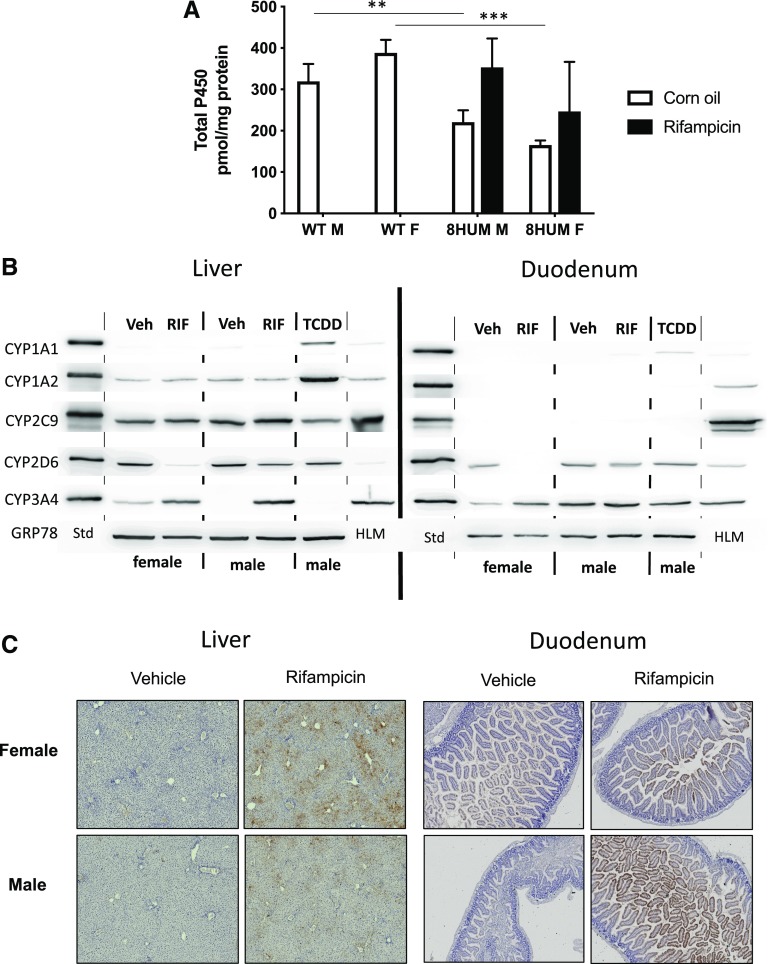
Expression of human cytochrome P450s in 8HUM mice. (A) Total hepatic P450 was determined from the carbon monoxide difference spectra (as described in Materials and Methods) in untreated male and female wild-type mice (WT; n = 3–8), and male and female 8HUM mice (n = 3) vehicle (white bars) and rifampicin-treated daily for 3 days (black bars; 10 mg/kg, i.p.). Data shown are mean ± S.D.; t test (two-tailed P values), statistically significant **P < 0.01; ***P < 0.001. (B) Immunoblot analysis of human P450 expression in liver and duodenum. Western blots were carried out on pooled microsomal fractions (n = 3) of liver and duodenum, as described in Materials and Methods, using antibodies specific for the human P450s shown. Std, His-tagged P450 standard; TCDD, 2,3,7,8-tetrachlordibenzodioxin-treated; Veh, vehicle-treated. (C) Immunohistochemical localization of CYP3A4 in liver and duodenum of vehicle- and rifampicin-treated 8HUM mice. Liver and duodenum from adult female 8HUM mice—vehicle- or rifampicin-treated for 3 days at 10 mg/kg i.p.—were processed for immunohistochemical staining as described in Materials and Methods. Photomicrographs shown are representative of n = 3.